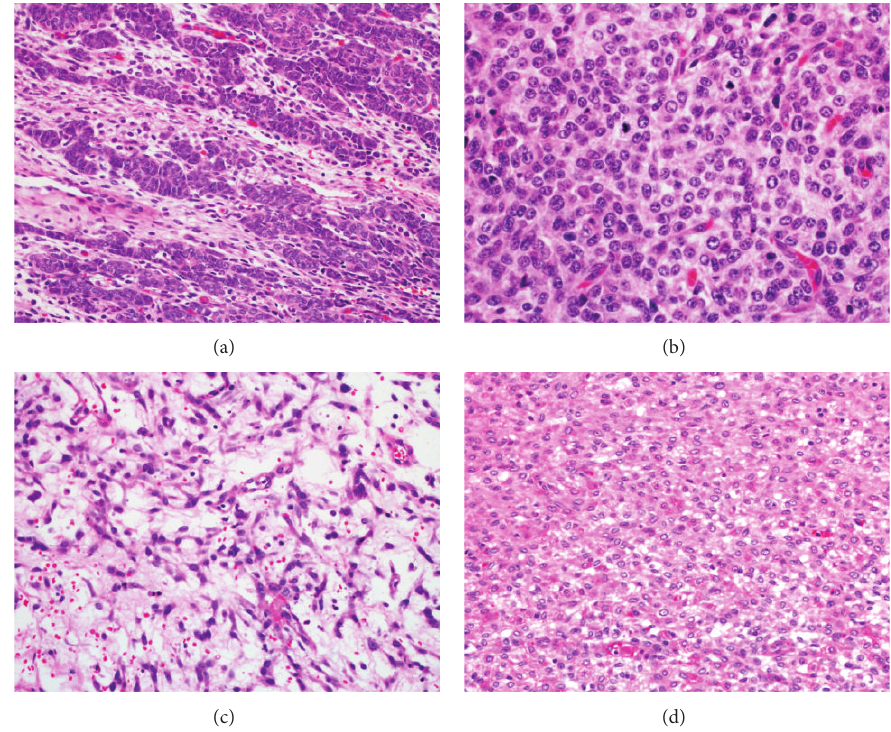
Figure 3: Microscopic examination of the left ovarian mass. (a) The ovarian mass was composed of immature, poorly differentiated, and spindle-shaped Sertoli cells forming cords and ill-defined tubules (H&E stain, magnification power: 20x). (b) The neoplastic Sertoli cells exhibited nuclear atypia and high mitotic indices (H&E stain, magnification power: 40x). (c) Focal myxoid area containing spindle-shaped cells was identified (H&E stain, magnification power: 20x). (d) Infrequent Leydig cells with eosinophilic cytoplasm were identified focally (H&E stain, magnification power: